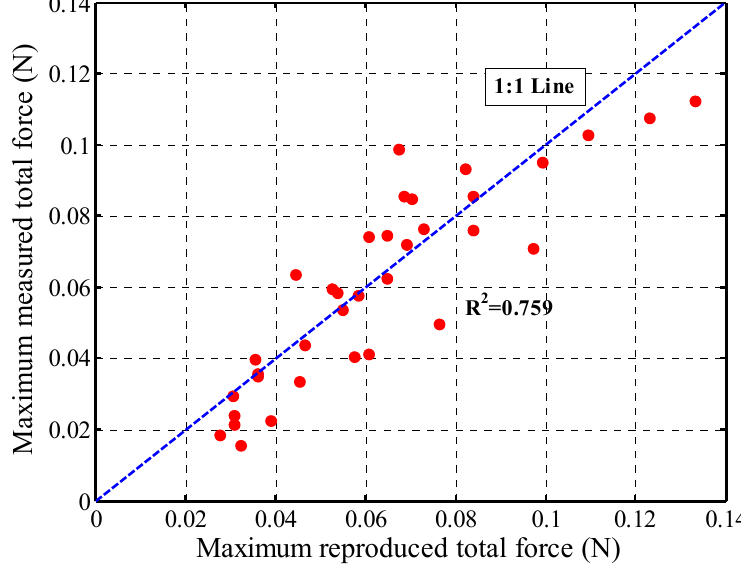
Figure 10. Comparison between the maximum reproduced total acting force ( F rep ) and the measured maximum total force at three functional measuring locations in all the tested cases.